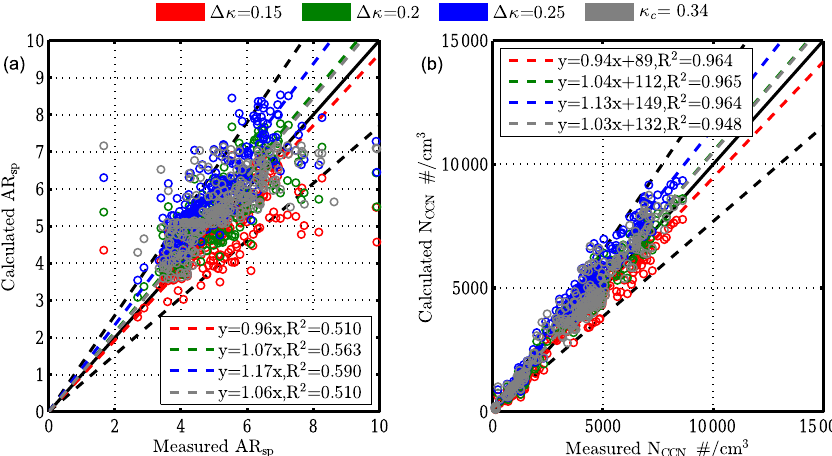
Figure 5. (a) Comparisons of calculated AR sp and measured AR sp with different conversions of κ c from κ f . (b) Regressions of calculated N CCN and measured N CCN with different conversions of κ c from κ f